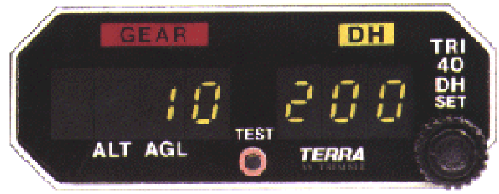
Figure 7. FreeFlight TRA-3500 radar altimeter with a height limit of 2500ft ( ∼ 750m) (source: (n.d.) from http://www.seaerospace. com/terra/tri40.htm, last access: 4 November 2015, reprinted with permission as per